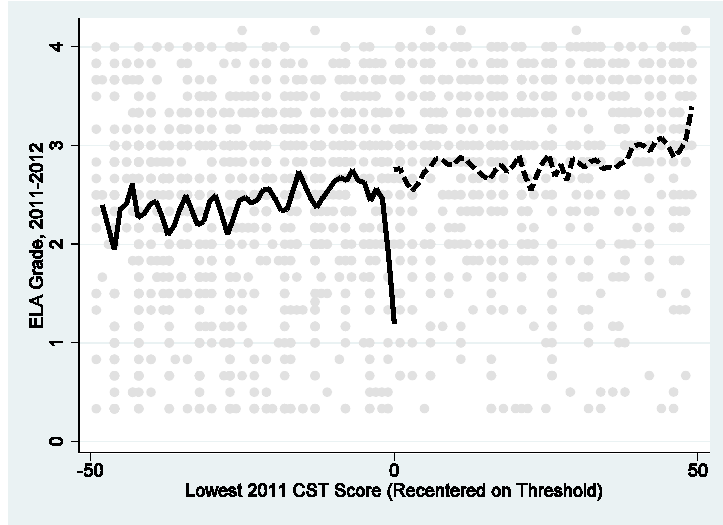
Figure S6: Regression discontinuity analysis of the effect of white card placement on Spring 2012 ELA grades, for 2011-12 Live Oak and Mann students (preferred bandwidth: